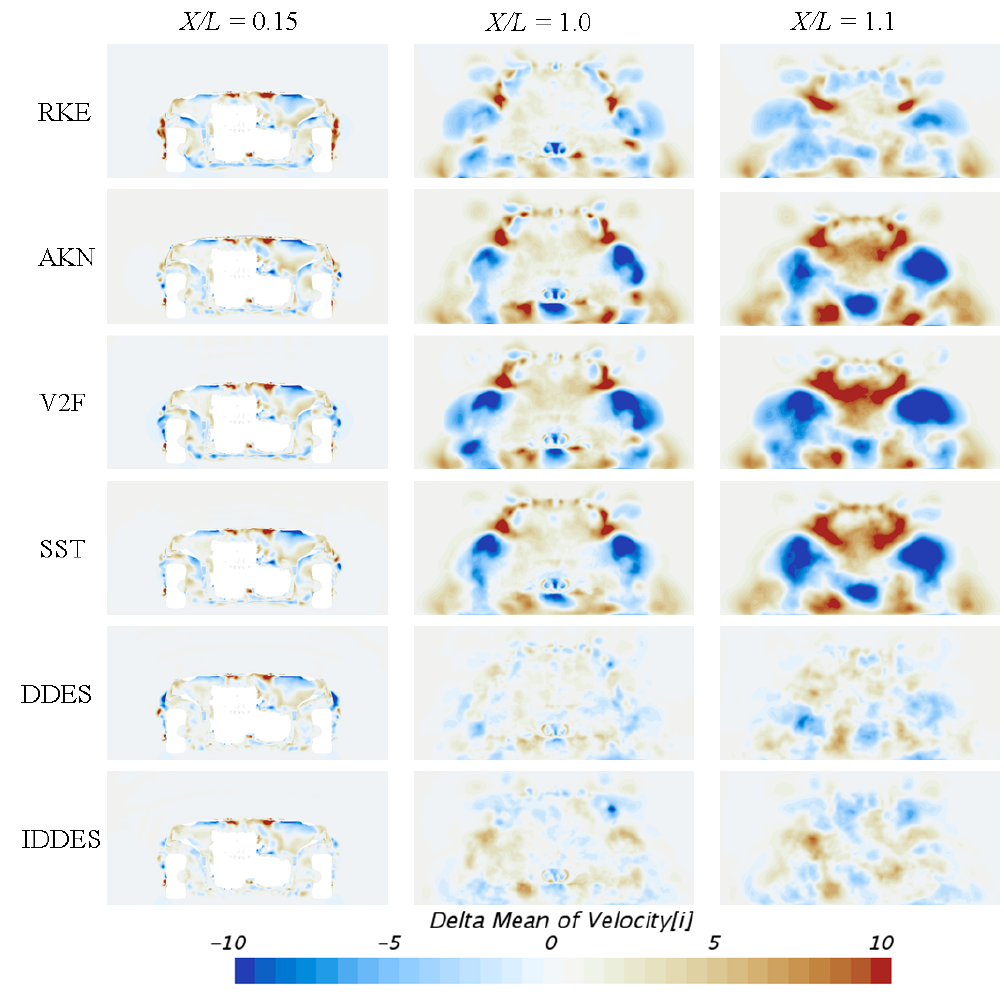
Figure 19. Delta streamwise velocity on selected plane sections against the IDDES fine for all other models for the baseline